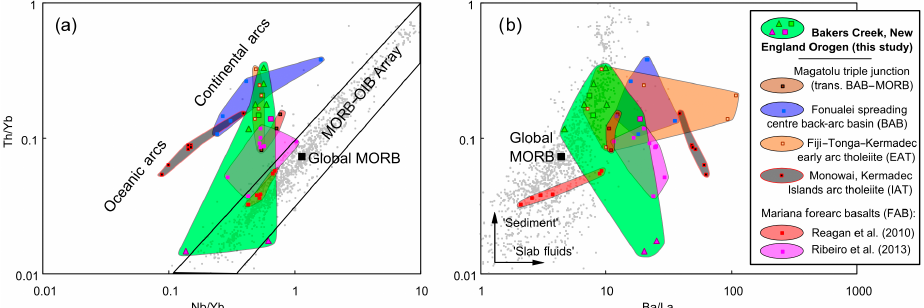
Figure 8. Indicators for subduction zone components, using Th / Yb as a proxy for sedimentary melt, versus (a) Nb / Yb identifying depletion of Nb, after classical subduction zone signatures (Pearce, 2014). (b) Ba / La as a proxy for a fluid-mobile component (Woodhead et al., 2001). Bakers Creek Suite compositions and selected primitive melts from western Pacific arc systems as for Fig. 7.